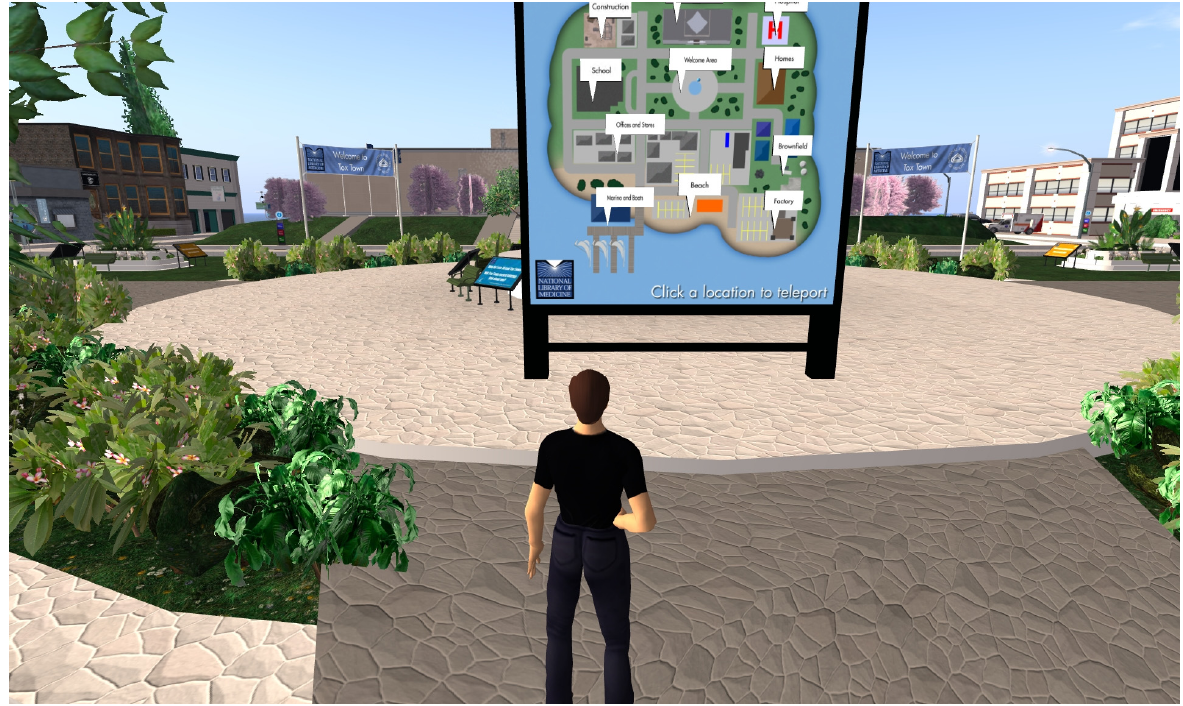
Figure 7. Tox Town’s HUD in Second Life ® . The HUD can be repositioned around the user’s screen according to user’s preference.